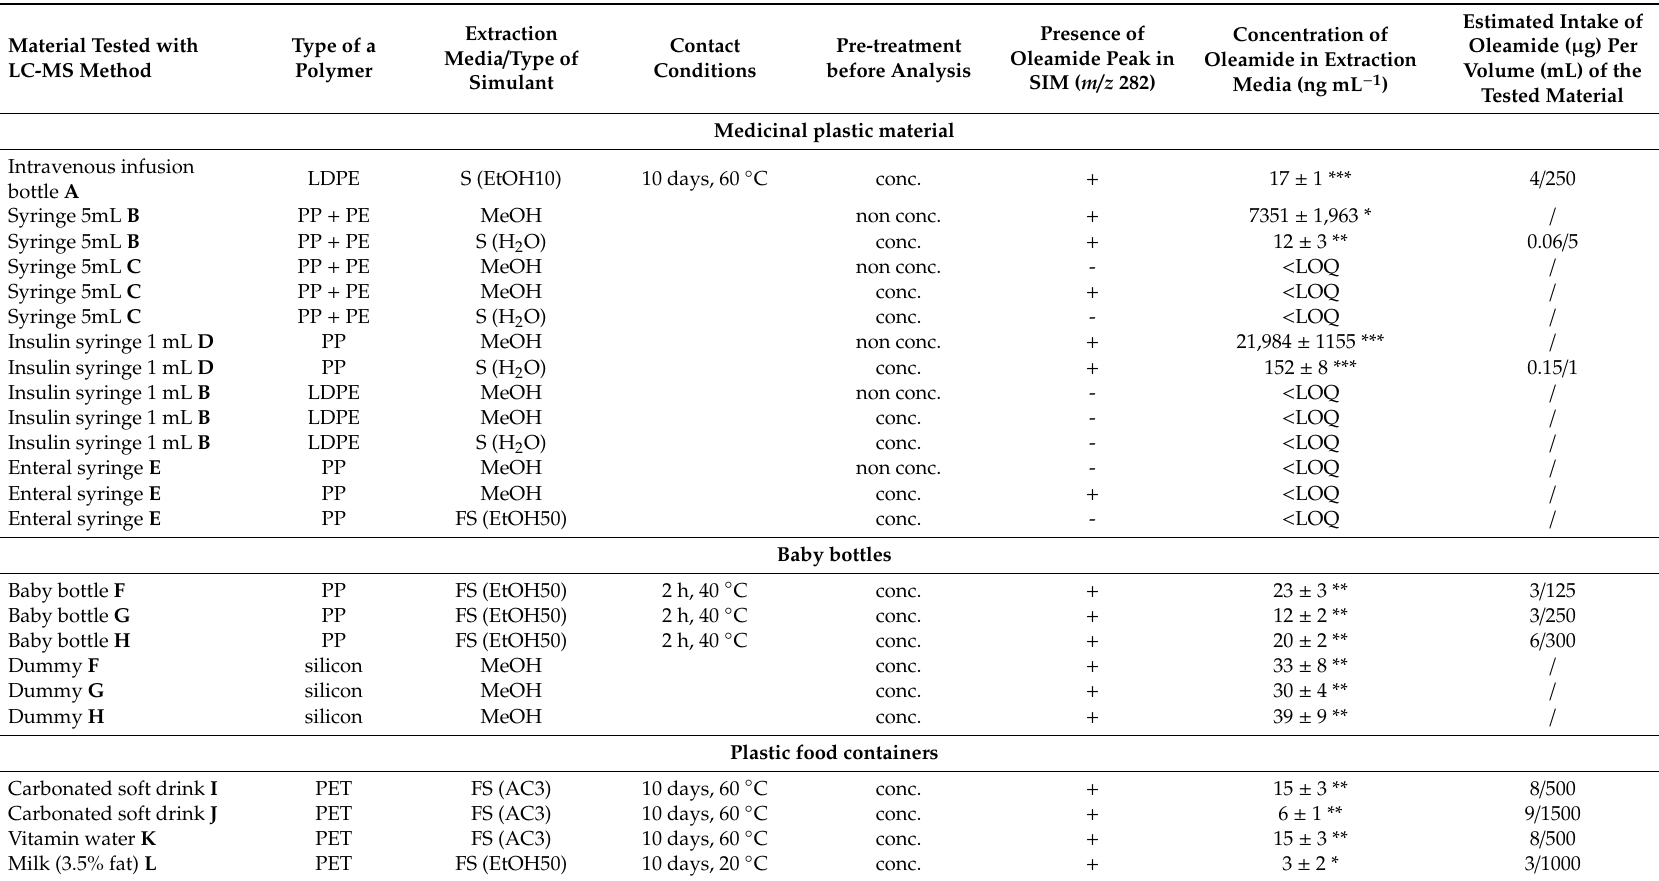
Table 1. Disposable medicinal and food / beverage containers tested for oleamide leaching by the LC-MS method together with the estimated intake of oleamide per volume of the tested material. Data for the concentration of oleamide in extraction media represent means ± standard deviation (SD) ( n = 3); paired t-test